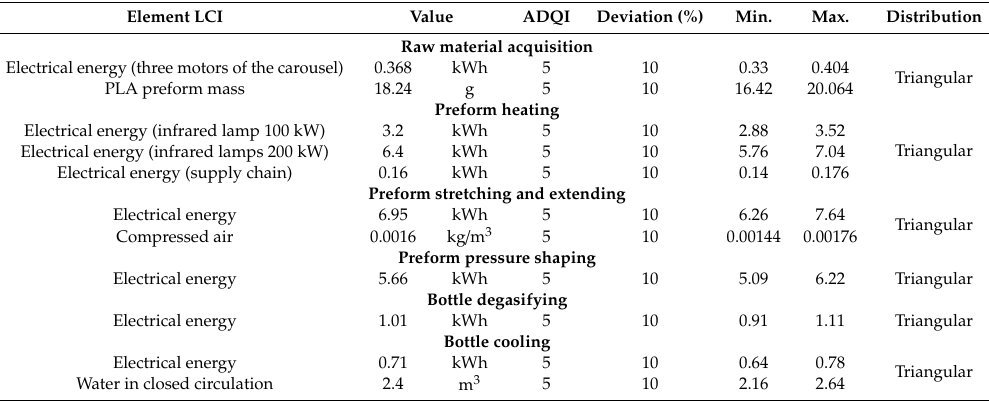
Table 5. Values of the minimum and maximum for inventory elements of the process of polylactide bottle manufacturing.